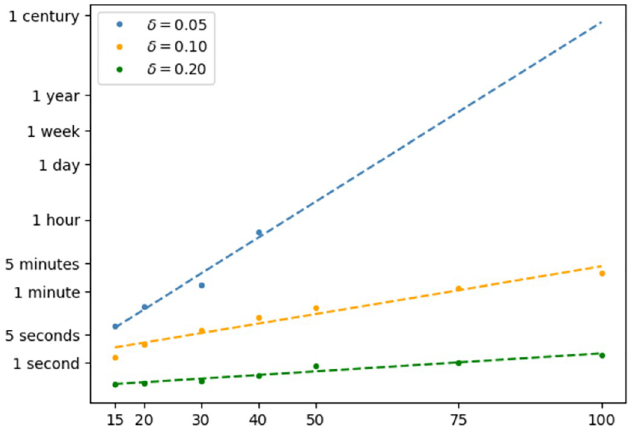
Fig 10. Time complexity of hi PRS. Fitting times of hi PRS for different values of δ and different numbers of SNPs ( x - axis). For better readability, the y -axis is reported in logarithmic scale. Dashed-lines are obtained via